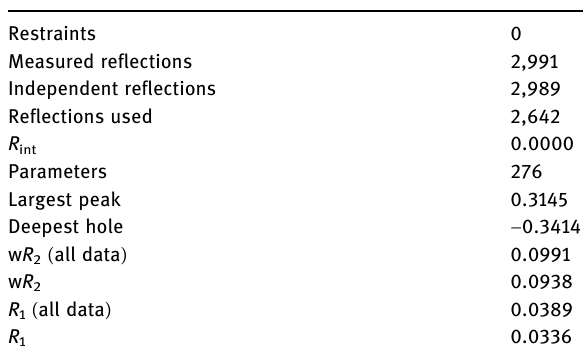
Table S2. Bond lengths in Å and bond angles in ° for H Cl N OS are given in Tables S3 and S4, respectively. C 16 17 2 3